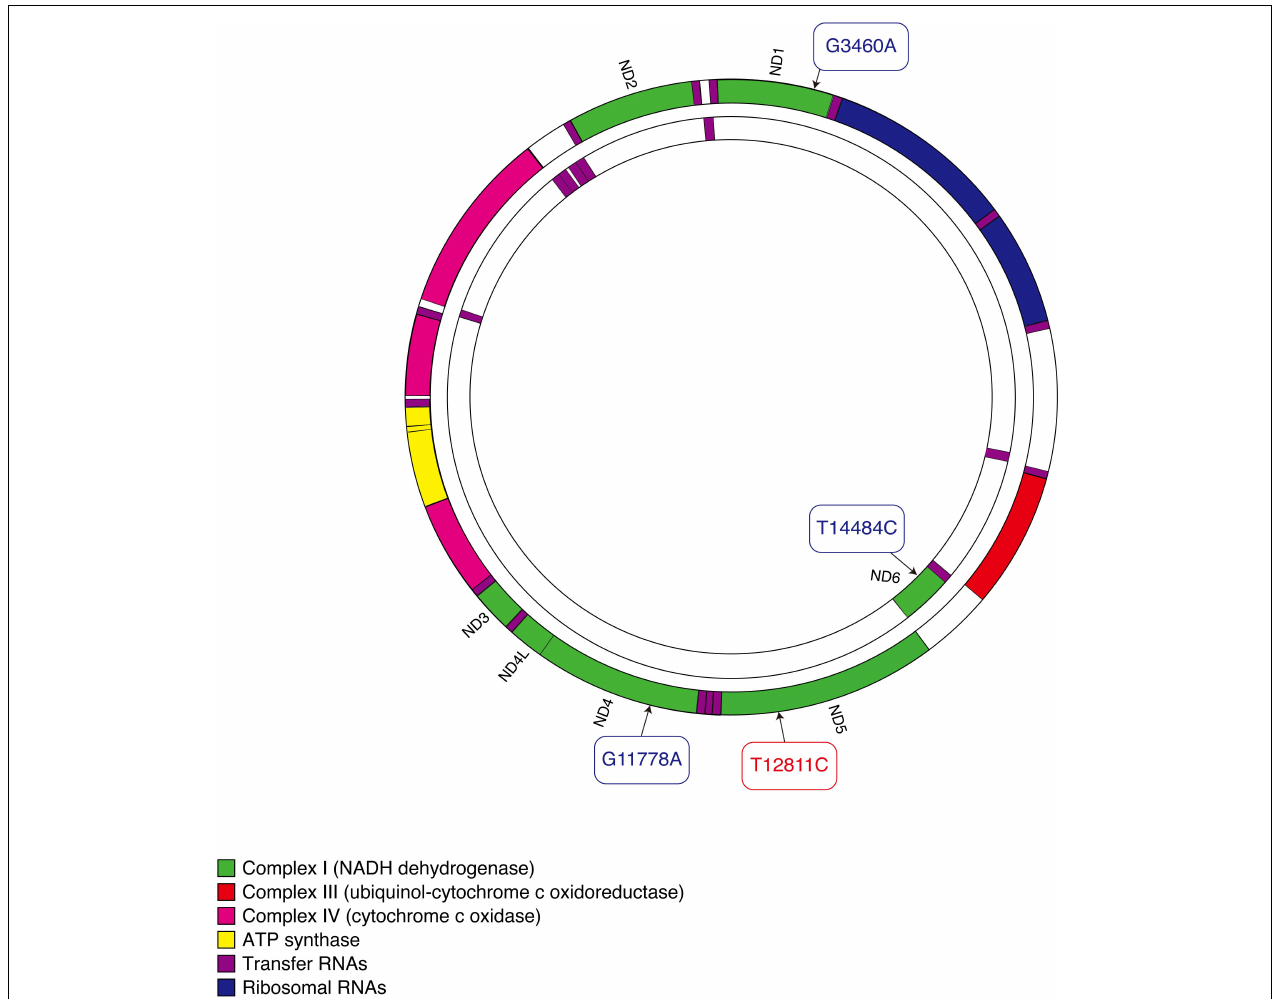
FIGURE 5 | Schematic diagram of mitochondrial DNA. Three primary mutations causing LHON are shown in blue. The mutation that our patients carried is shown in